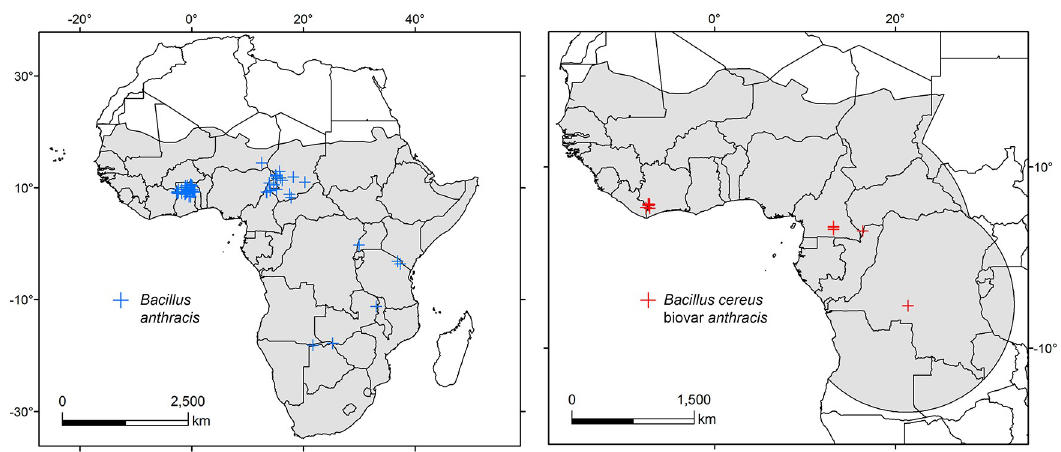
Fig 1. Occurrence points and calibration areas. Confirmed records of Bacillus anthracis (blue) and Bcvba (red) with their corresponding calibration areas (gray shading). Maps were developed using shape files of Africa from the public domain repository of Natural Earth (http://www.naturalearthdata.com/) and built with ArcGIS 10.3 (ESRI Redlands, CA,